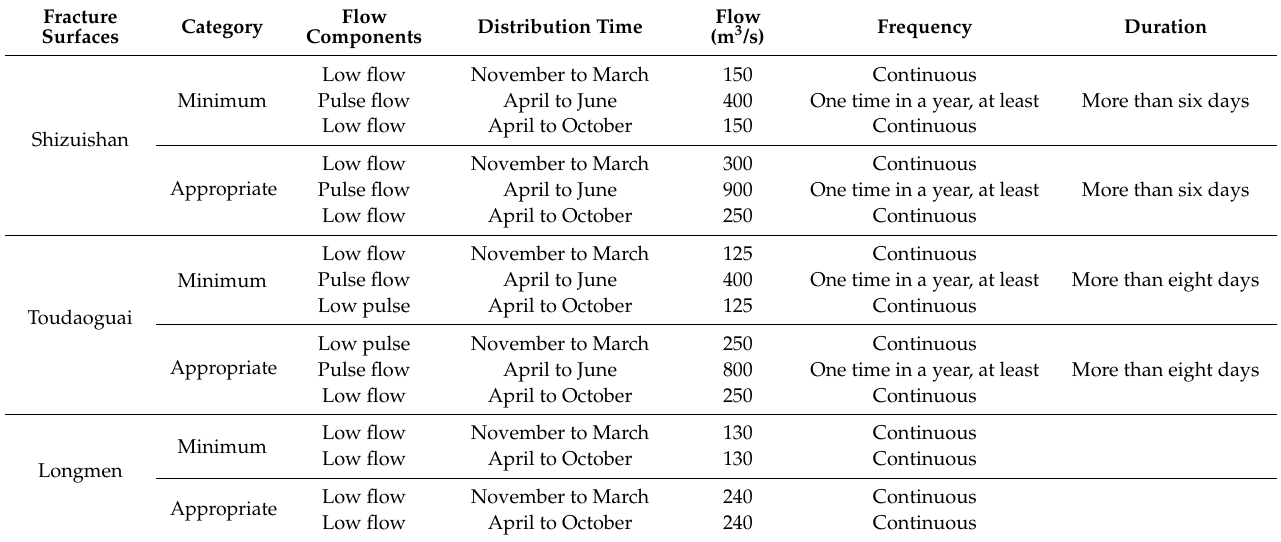
Table 2. Ecological flow demand of fish at the stations in Shizuishan, Toudaoguai,